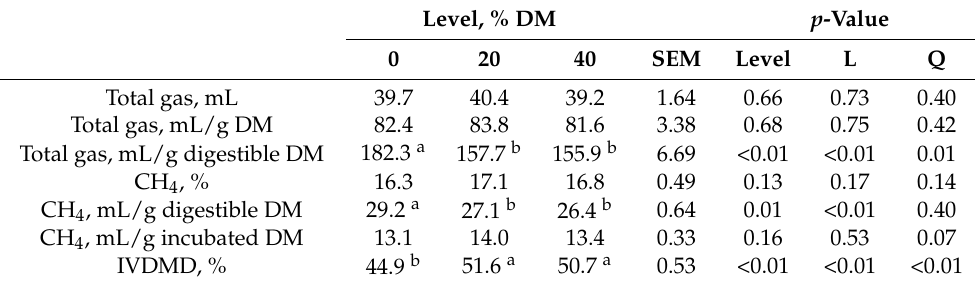
Table 5. In vitro fermentation, gas, and methane production parameters of sorghum ensiled with 0, 20, or 40% DM unsalable vegetable mixture, with or without a probiotic inoculant after 24 h in vitro batch culture incubation.